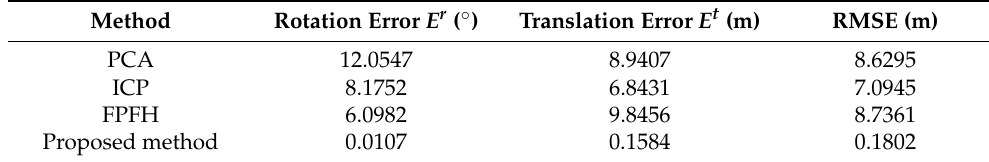
Table 2. Alignment accuracy parameters of Experiment